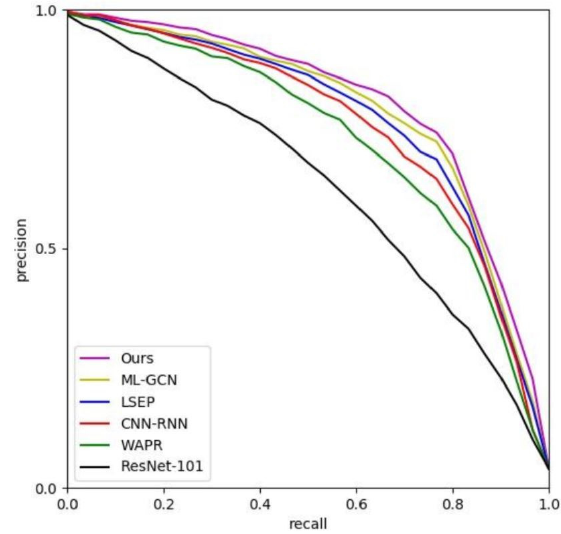
Figure 13. Average precision–recall curves on